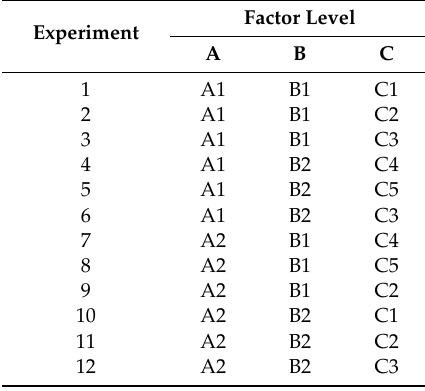
Table 2. The experiments and their combination of control factors in the L12 orthogonal array.